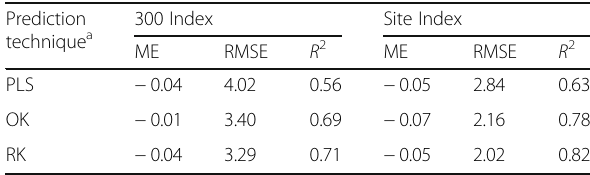
Table 1 Validation statistics obtained using validation data set for various techniques for predicting the 300 Index and Site Index. Shown are the mean error (ME), root-mean-square error (RMSE) and proportion of variance explained ( R 2